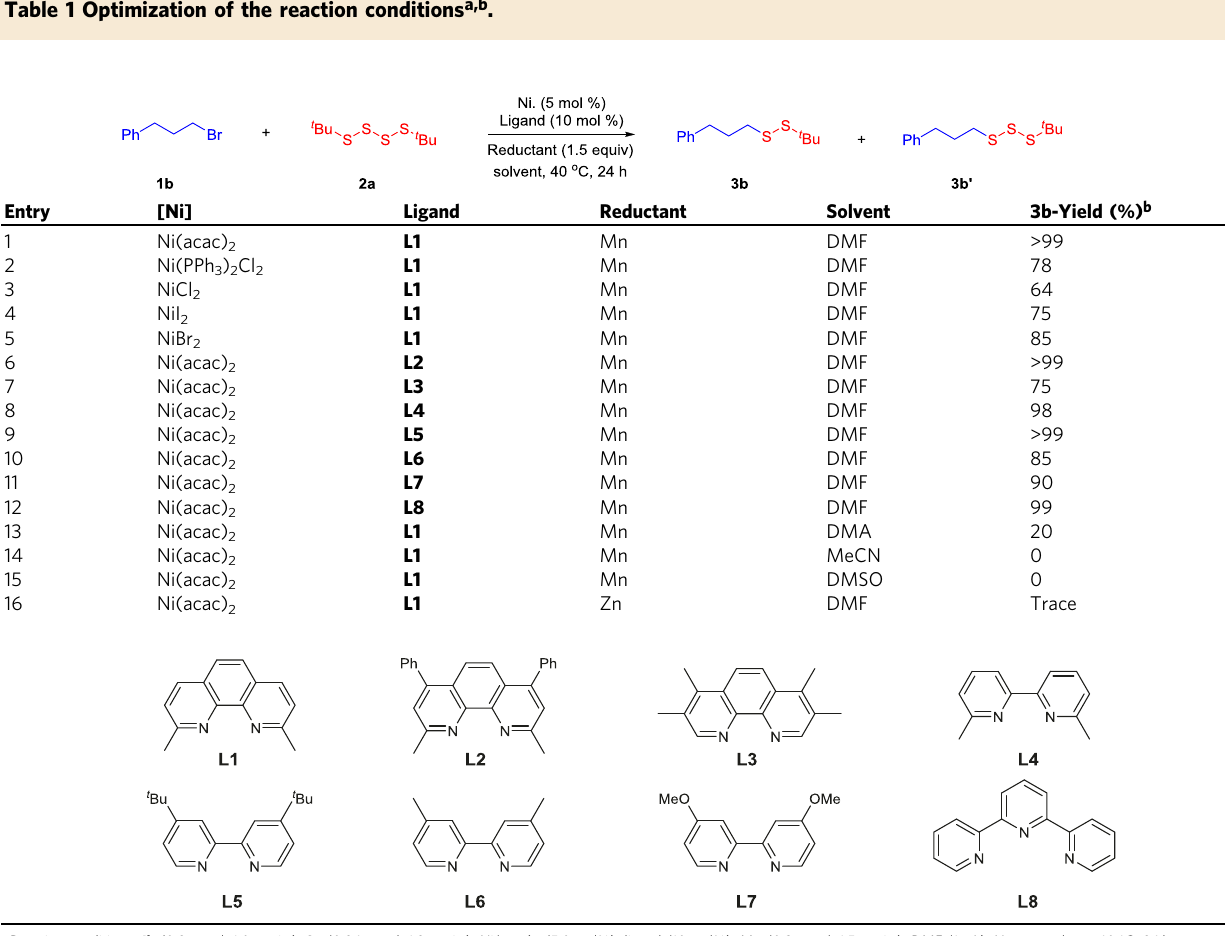
Fig. 2 Strategies for unsymmetrical disul fi de assembly. a Traditional disulfuration by S – S bond formation. b Direct disulfuration via masked strategy. c Radical substitution on tetrasul fi des. d Nickel-catalyzed reductive thiolation on tetrasul fi des. Table 1 Optimization of the reaction conditions a,b